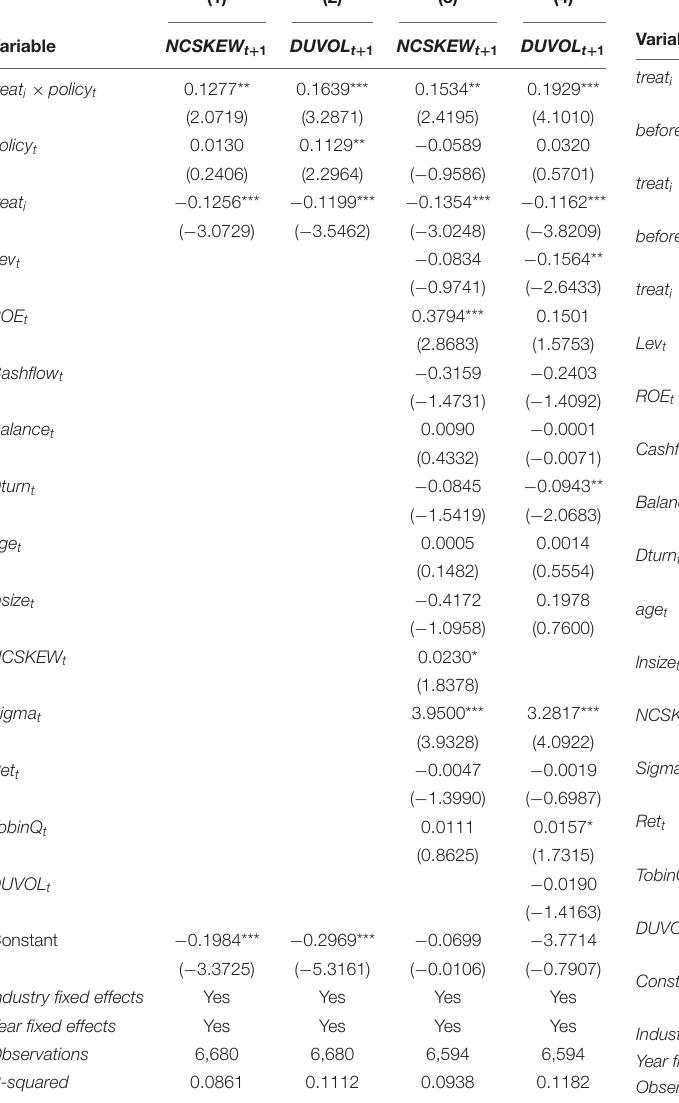
Table 1 provides the summary statistics. The variables of NCSKEW and DUVOL have a mean value of − 0.2417 and − 0.1834 and a standard deviation of 0.9144 and 0.7435, respectively. This indicates that the two variables